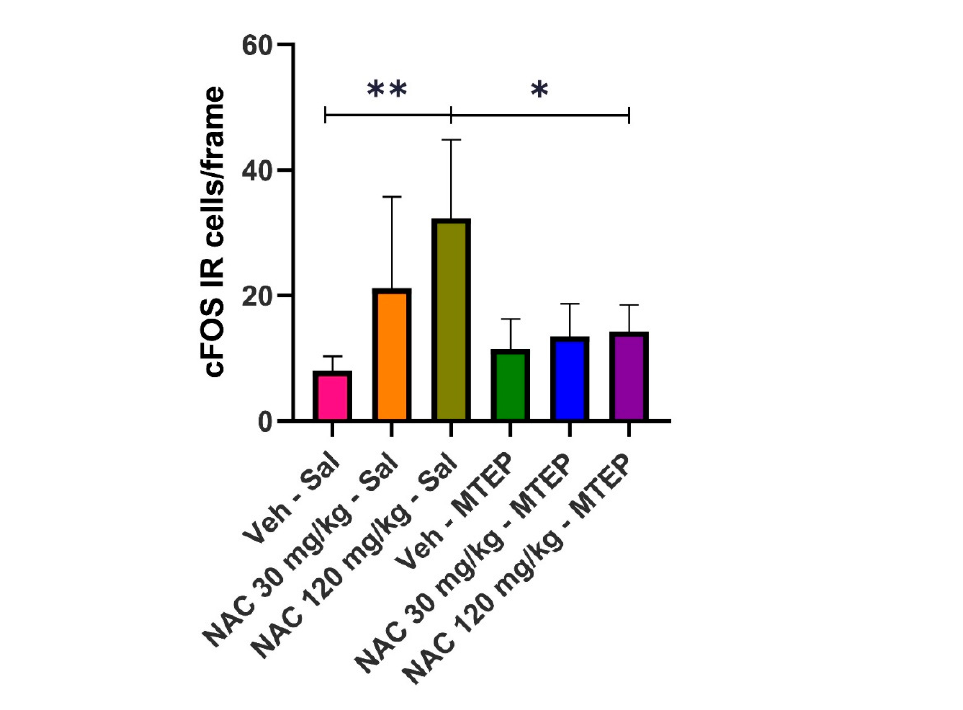
Figure 1. Effect of MTEP administration on cFOS IR-cell expression, induced by low (30 mg/kg) and high doses (120 mg/kg) of NAC. Data are mean ± SD, and represent the number of cells per frame. Asterisks indicate the existence of statistical differences between the marked groups. (Tukey’s test: * p < 0.05, ** p < 0.01).